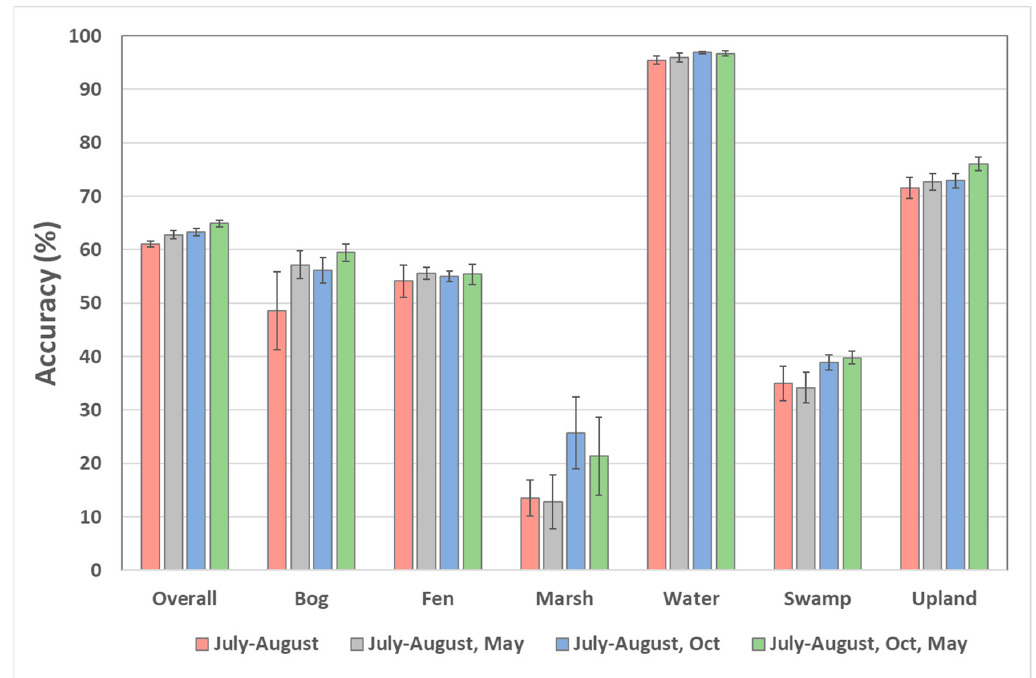
Figure 7. Overall accuracy for ABMI_PP with addition of seasonal Landsat composites based on the spatial extension assessment and best-test training convergence. Class accuracies are the mean F1-score across the five iterations of CNN training. Error bars represent the standard deviation across training iterations.